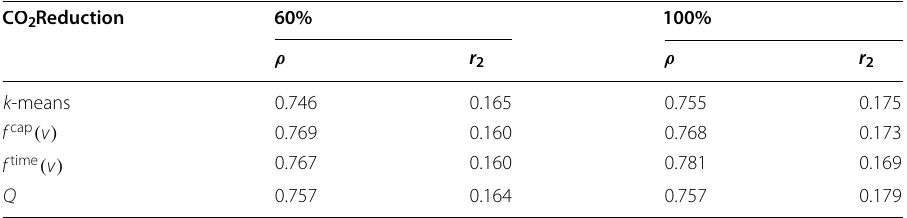
Table 2 Bivariate correlation factor ρ and radius of the minor axis r n of the PDF of power flows in Fig. 9 according to equation (11) for each respective clustering method and carbon reduction target for a spatial resolution of 97 nodes